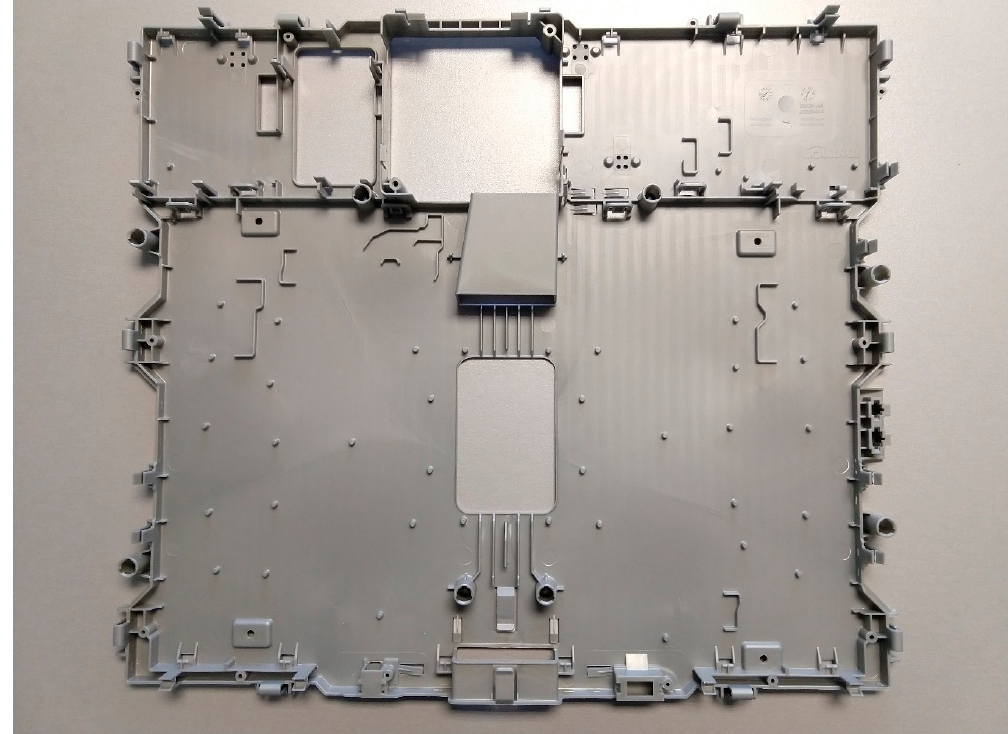
Figure 1. Sample component used for the analysis.